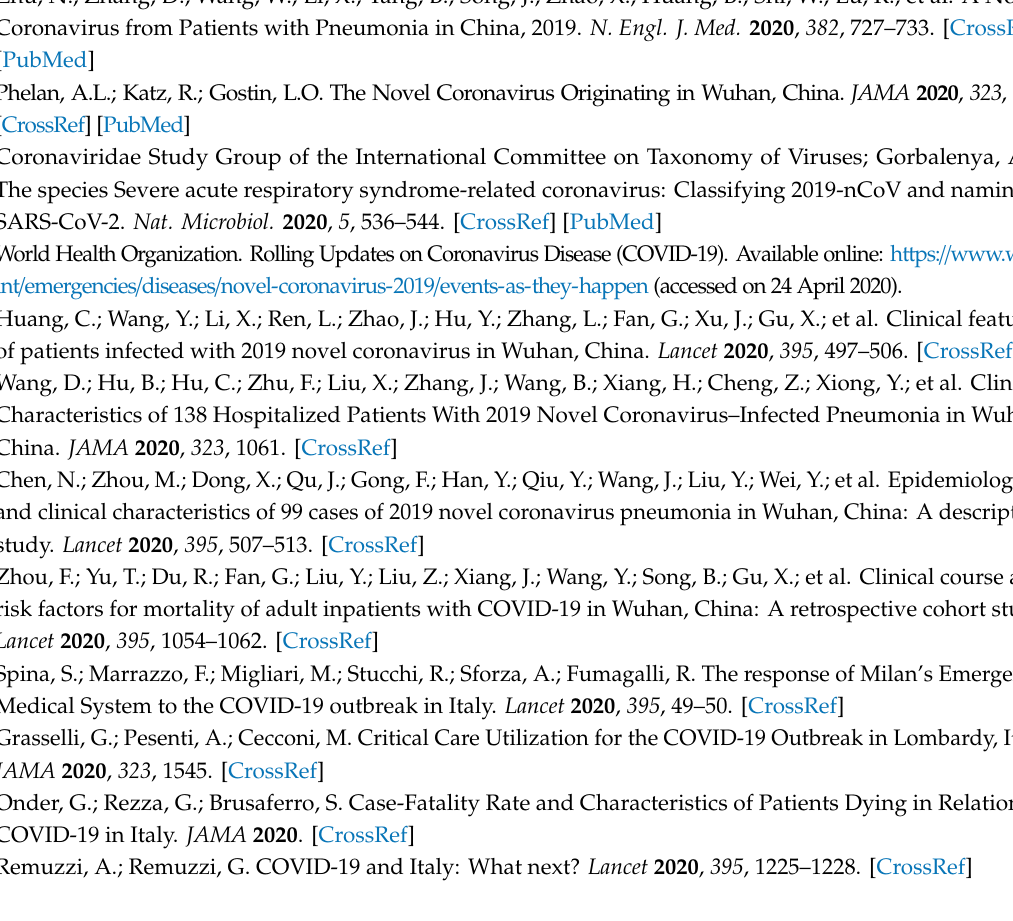
Figure S1: Predictors of clinical deterioration, leading to ICU transfer or death, in hospitalized COVID-19 patients: univariable Kaplan–Meier survival curves, Figure S2: Clinical prediction index scoring algorithm, Figure S3: Calibration (Kaplan–Meier) curves showing optimal agreement between the prediction established by the prognostic score and the actual observation across the three risk-categories (i.e., the “low risk” category (upper curve), the “intermediate risk” (intermediate curve), and the “high risk” category (lower curve)), Table S1: Humanitas Covid-19 task